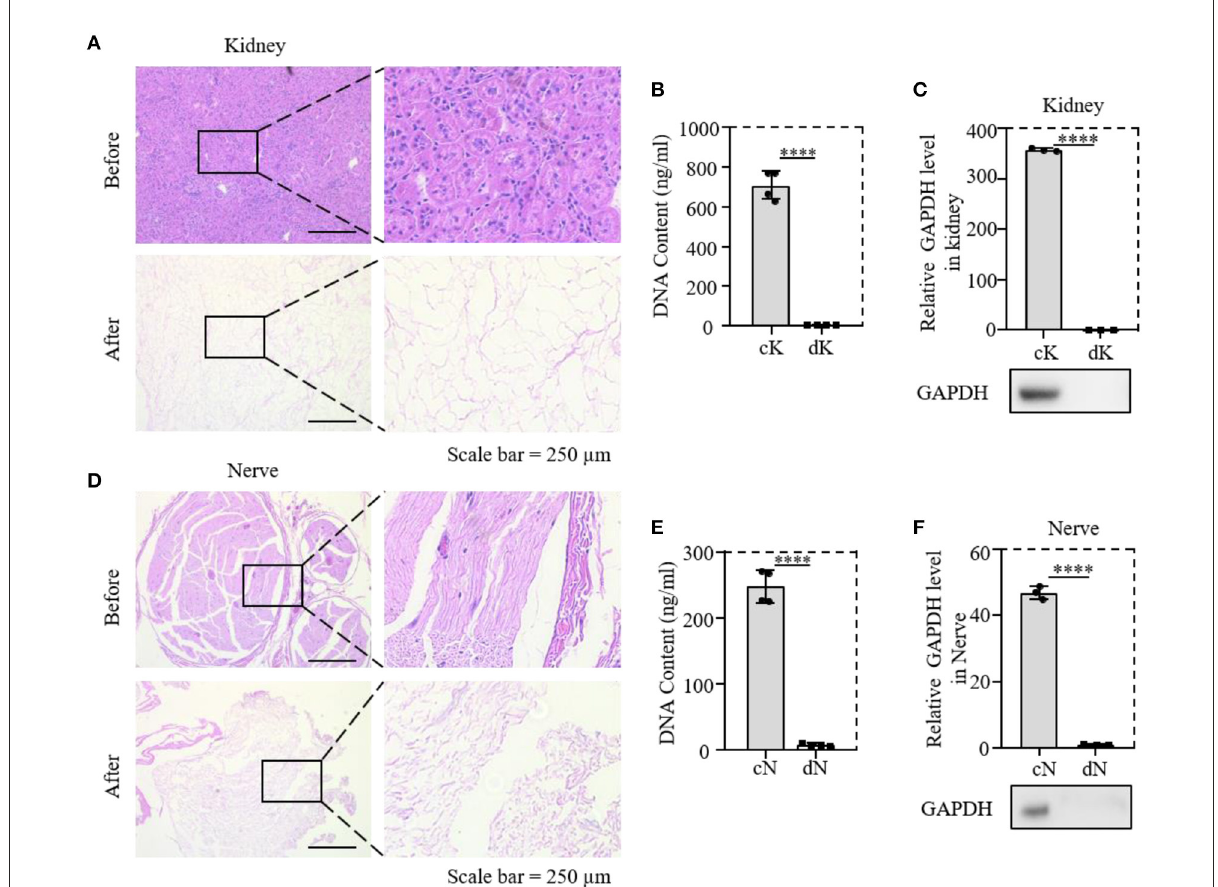
FIGURE1 Validation of the decellularized efficiency of kidney and nerve tissue; (A,D) comparison of H&E staining before and after decellularization of rat tissues; (B,E) comparison of DNA content in tissues before and after decellularization; (C,F) relative protein expression of GAPDH; cK, control kidney; dK, decellularization kidney; cN, control nerve; dN, decellularization nerve. **** P ≤